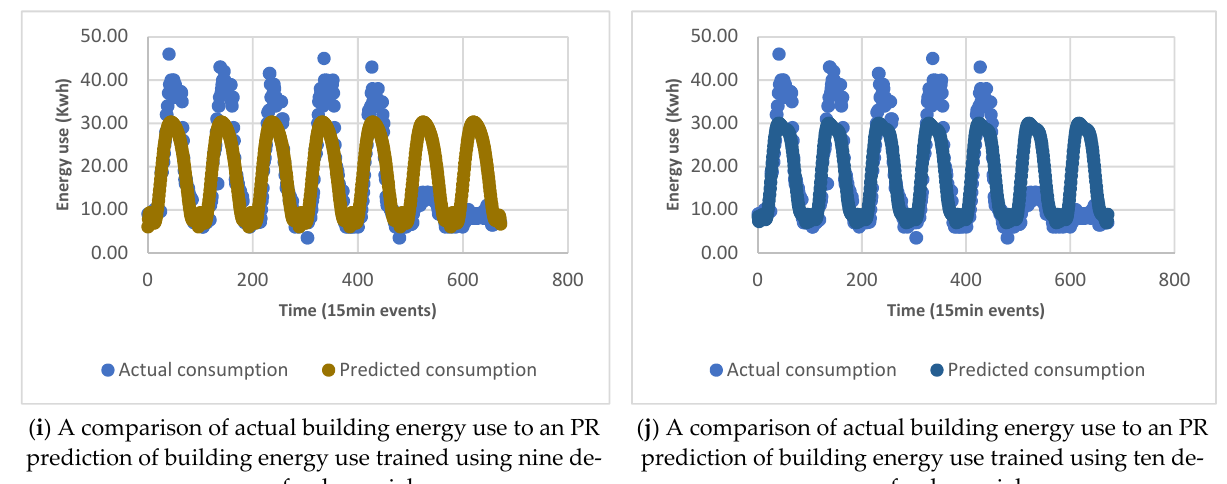
prediction of building energy use trained using ten de- grees of polynomial. Figure 9. A comparison of polynomial regression predictions to actual energy use.